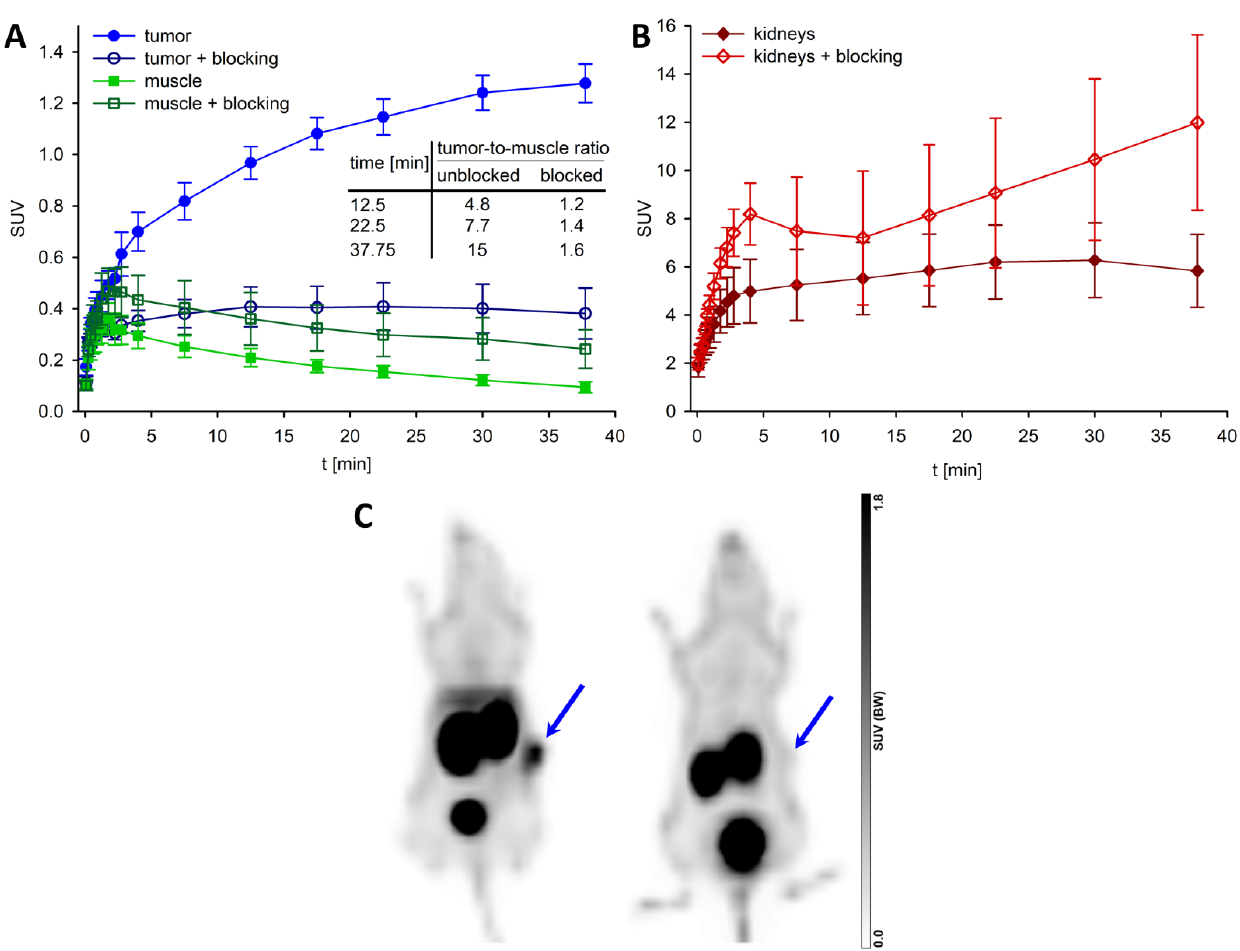
Figure 7. TACs and representative PET images from studies with [ 68 Ga] 56 in HT-29 tumor-bearing mice. ( A ) SUV mean ± SD (n = 4) from 45 min-PET scans for the tumor (circles) and muscle (squares), and tumor-to-muscle ratios for selected times calculated based on the SUV values (inset table). Blocking data were obtained by co-injection of 48 (560 – 700 nmol/mouse). ( B ) SUV mean ± SD (n = 4) for the kidneys (same PET scans as under ( A )). ( C ) Maximum intensity projections of two representative PET images of HT-29 tumor-bearing mice after injection of [ 68 Ga] 56 (left) or co-injection of [ 68 Ga] 56 and 48 (right) (time frame: 10 – 45 min p.i.). The blue arrows indicate the tumors.